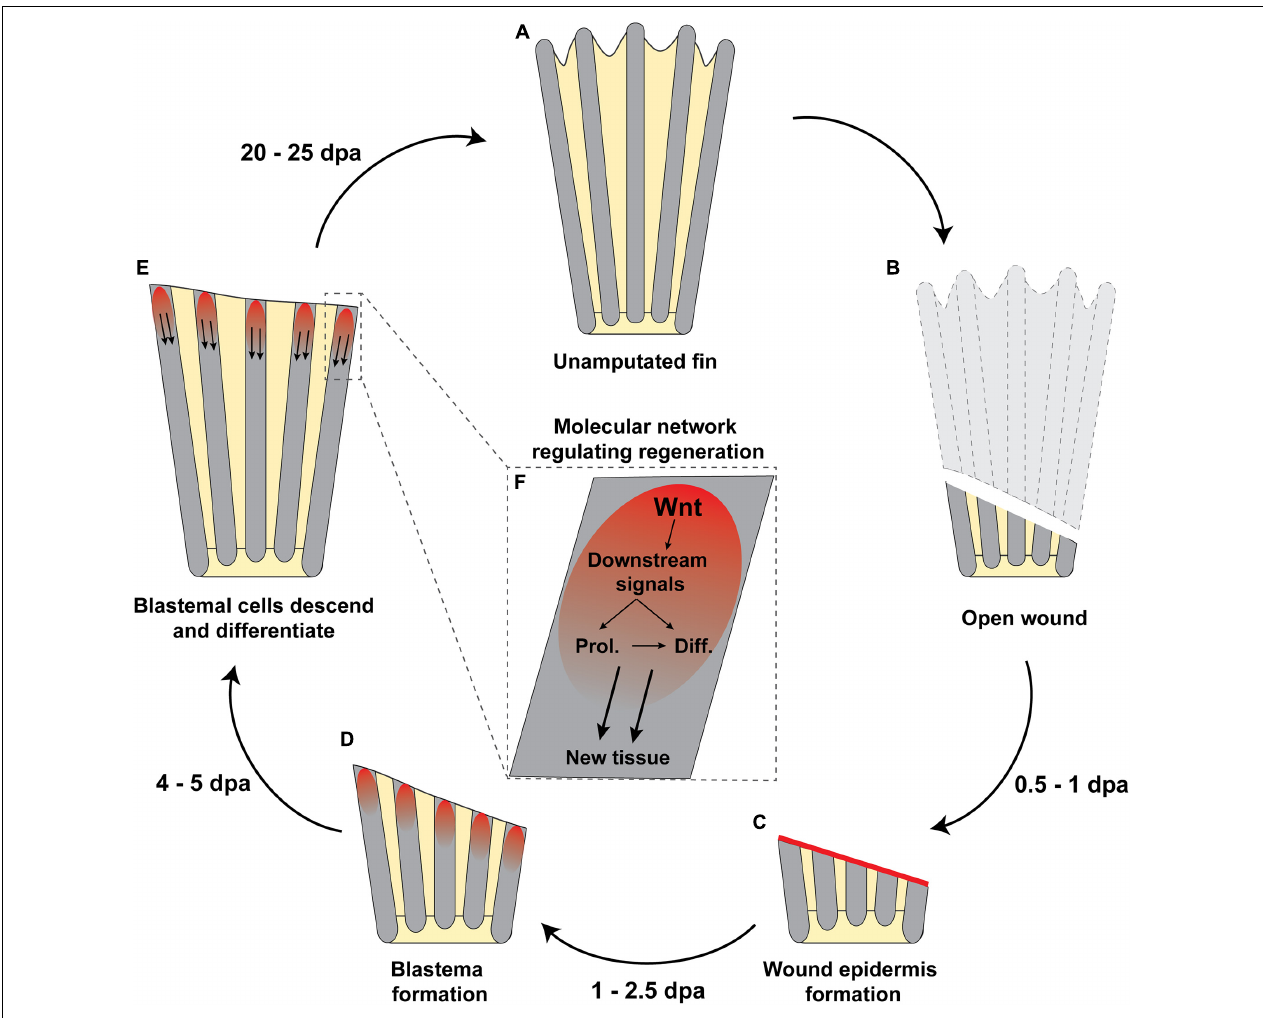
FIGURE 3 | Regeneration of the dermal skeleton in fish fins after injury. (A) Uninjured fin. (B) The regenerative process starts with an open wound from a partially amputated fin. (C) The open wound is rapidly closed by a wound epidermis (red line) within 1 day post amputation (dpa). (D) It is thought that wound epidermis initiates the blastema formation (red area in the most distal area of the fin), where (E,F) blastema cells descend upon Wnt and downstream signaling, which induce post-mitotic cells entering the cell cycle to proliferate (Prol.) and then differentiate (Diff.) to form the new tissue. (A) After 20–25 dpa, the newly regenerated fin is finished, completely reassembling the original structure. The outgrowth rate and accuracy of regeneration (homo- or heteromorphic) can vary depending on the